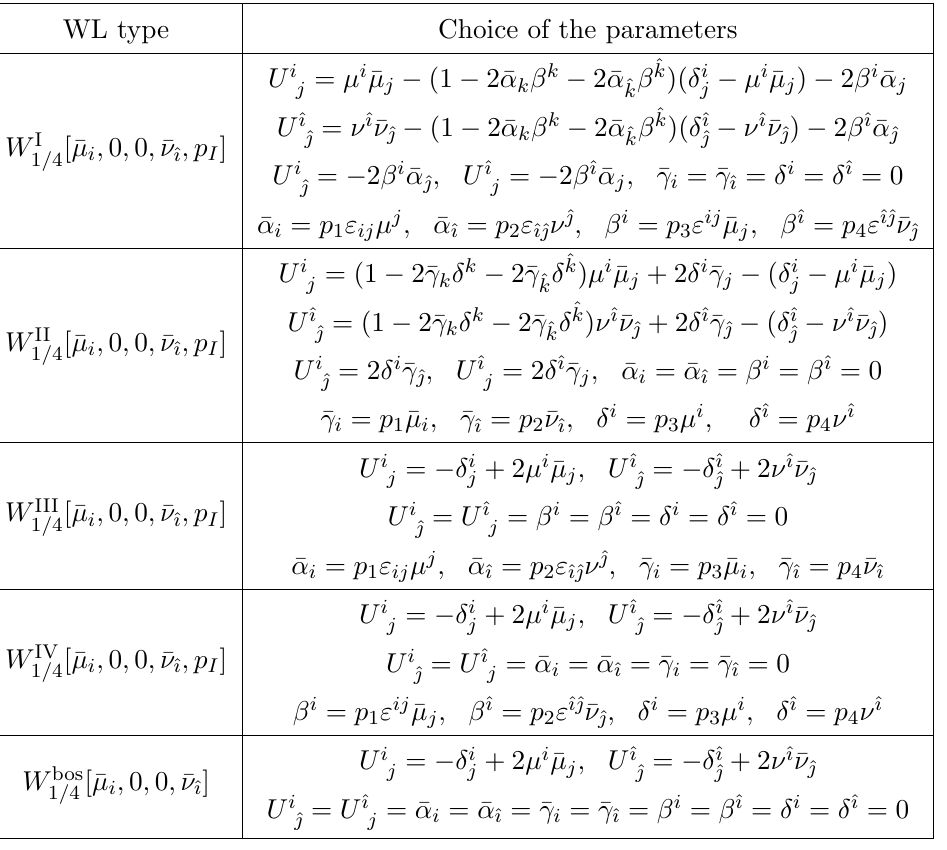
Table 2 . The four types of fermionic WLs and the bosonic 1/4 BPS WL in circular quiver N =